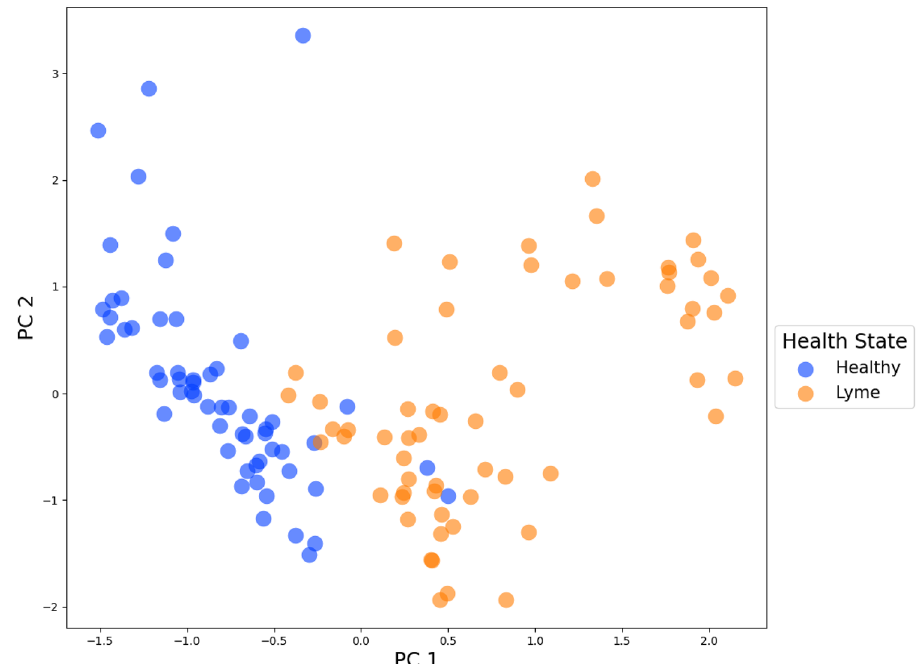
Figure 3. PCA visualization of log transformed and KNN imputed LC-MS data from training samples restricted to the optimal 45 features found by k FFS.